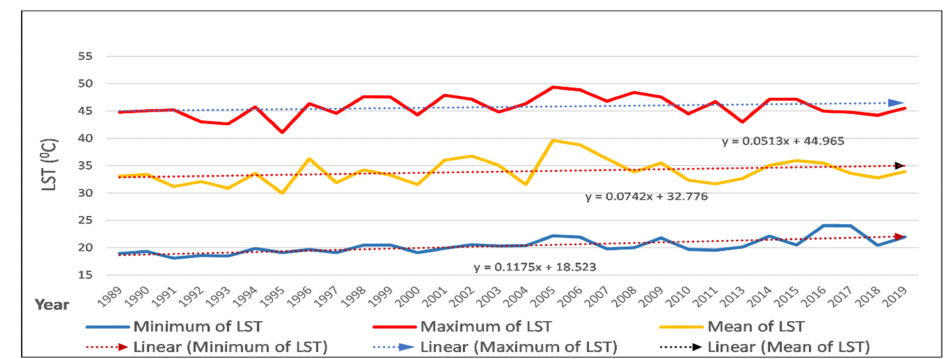
Figure 8. Minimum, mean and maximum value of LST from 1989 to 2019.